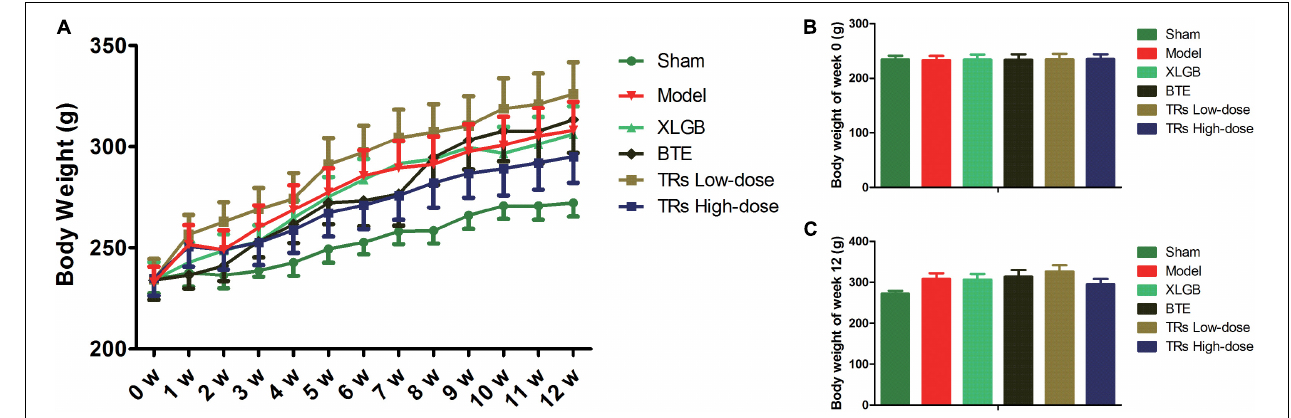
FIGURE 1 | Effects of black tea extract (BTE) and thearubigins (TRs) on body weight (g) in OVX rats. (A) Growth curve for each group, (B) the initial (week 0) body weight, (C) the final (week 12) body weight. The initial, weekly, and final weights of the rats were measured throughout the experiment and the data were recorded once a week. All data are presented as mean ± SEM ( n = 12). The data was analyzed using “Linear Mixed Models.” The model group vs sham group and each treatment group vs model group were analyzed,